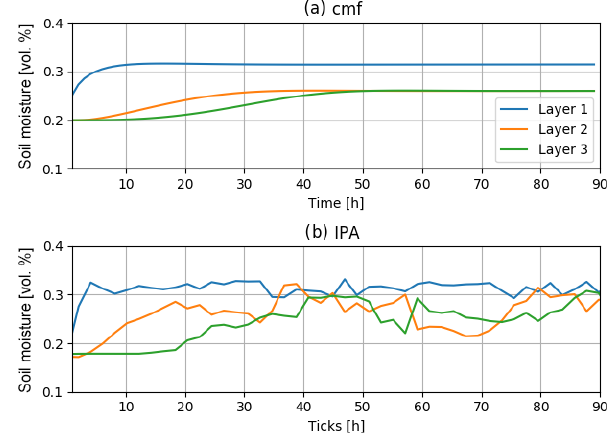
Figure 9. Modelled soil moisture without spline smoothing but log- arithmic kernel weight assignation.